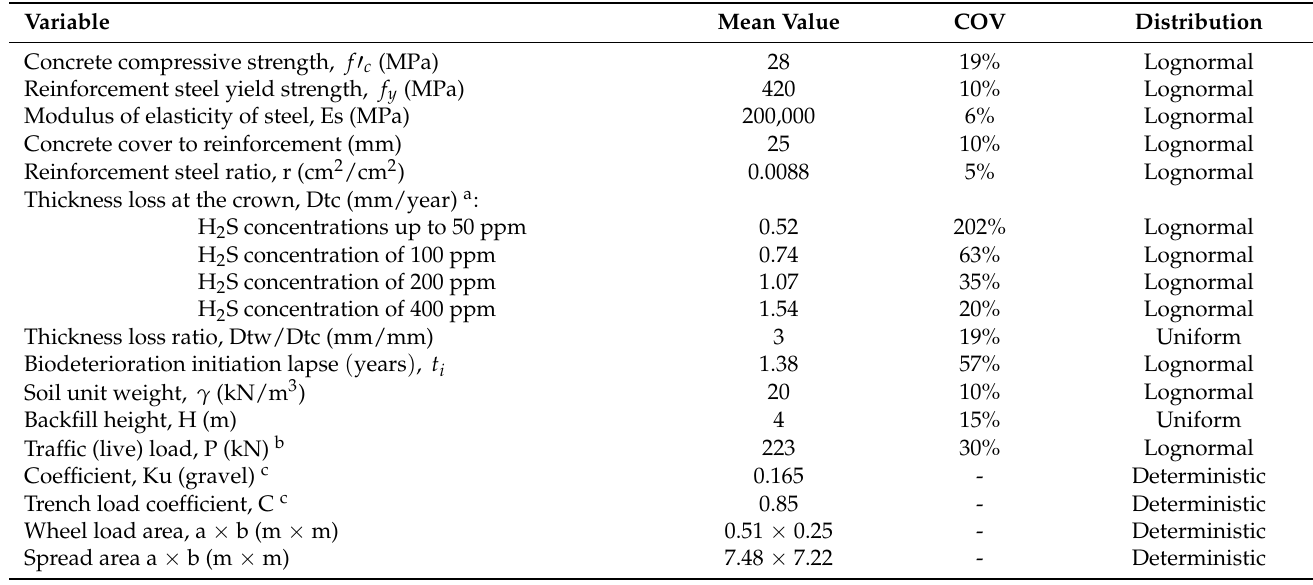
Table 2. Variables for the numerical example (references: